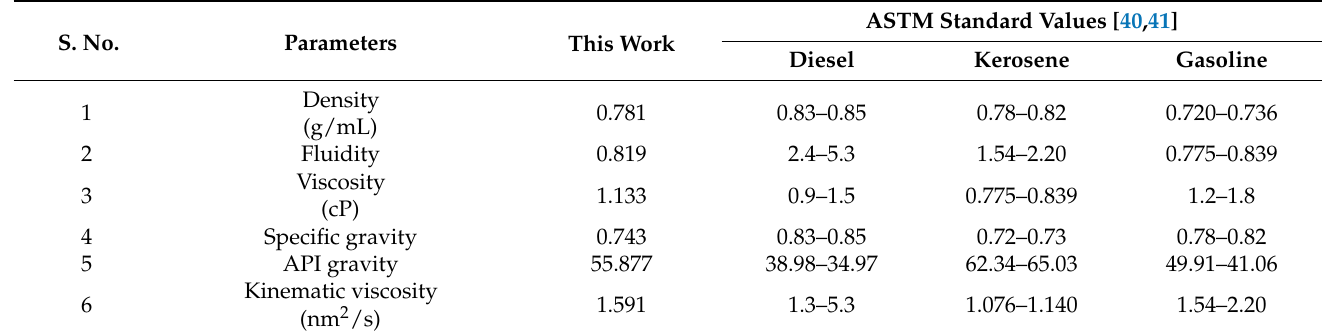
Table 2. Comparison of the fuel properties of the oil obtained from PP waste with ASTM standard